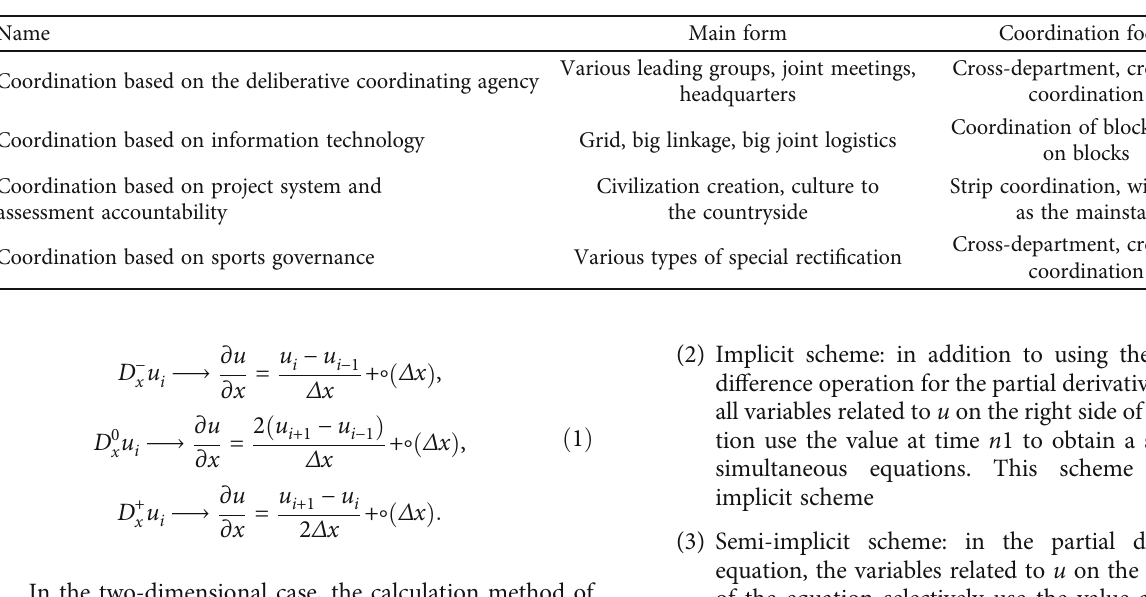
Table 1: Common coordination mechanisms in the government